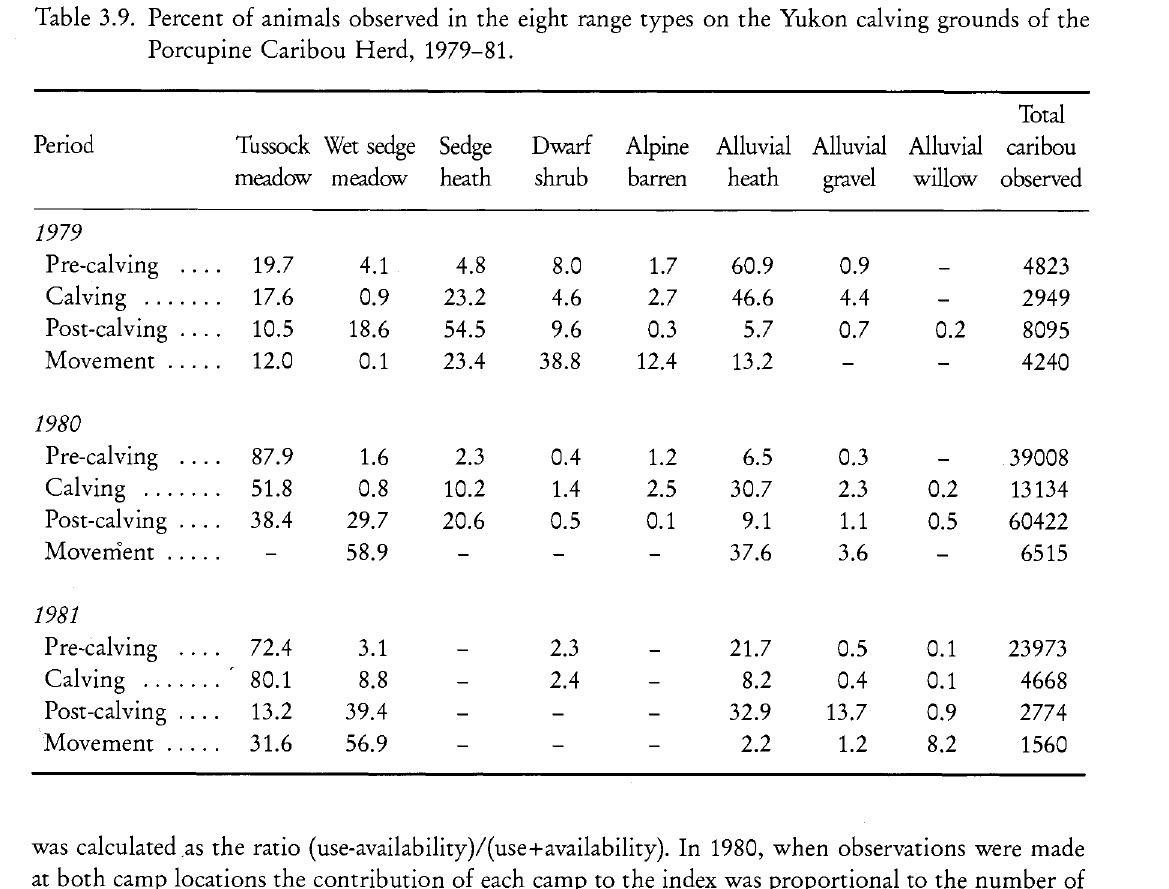
Table 3.9. Percent of animals observed in the eight range types on the Yukon calving grounds of the Porcupine Caribou Herd, 1979-81. Period Tussock Wet sedge Sedge Dwarf Alpine Alluvial Alluvial Alluvial caribou meadow meadow heath shrub barren heath gravel willow